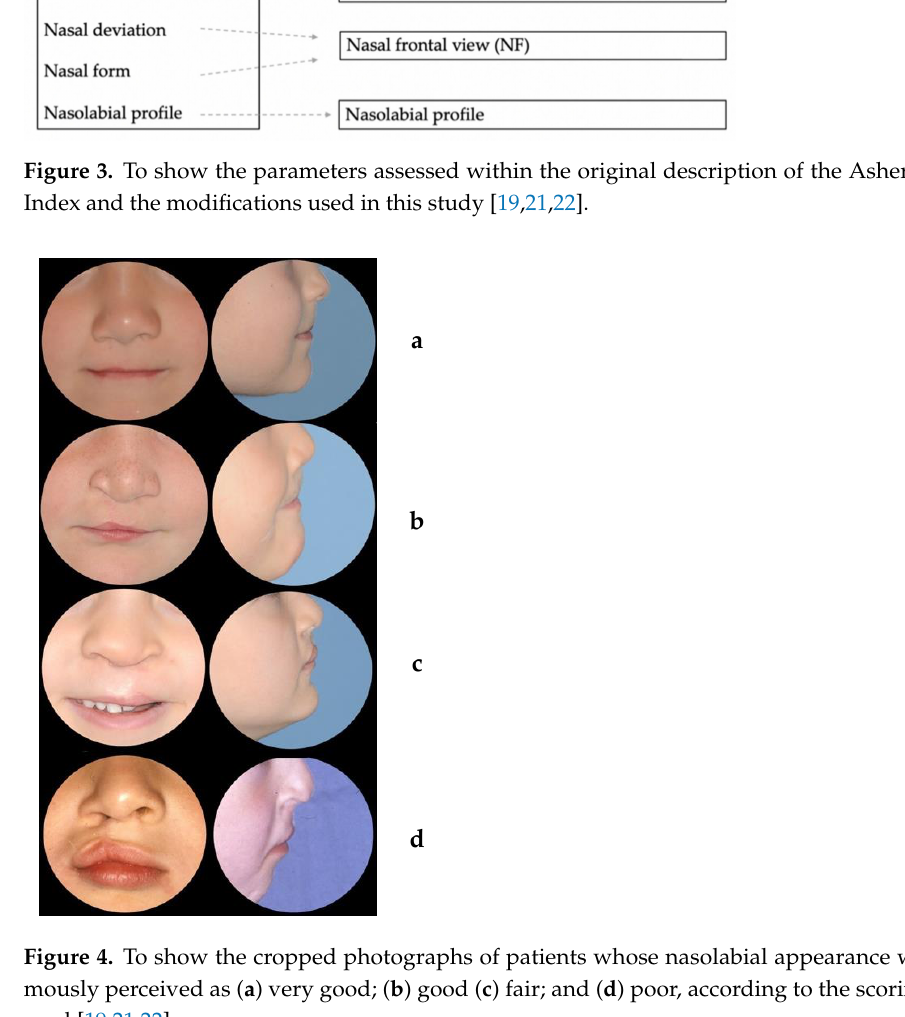
Figure 3. To show the parameters assessed within the original description of the Asher – McDade Index and the modifications used in this study [19,21,22].